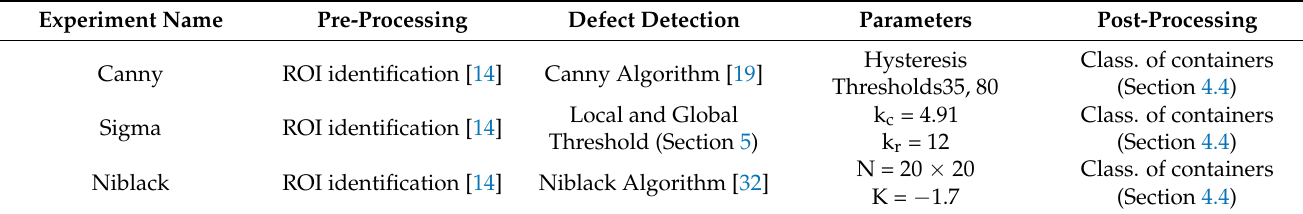
Table 2. Algorithms considered in the evaluation.